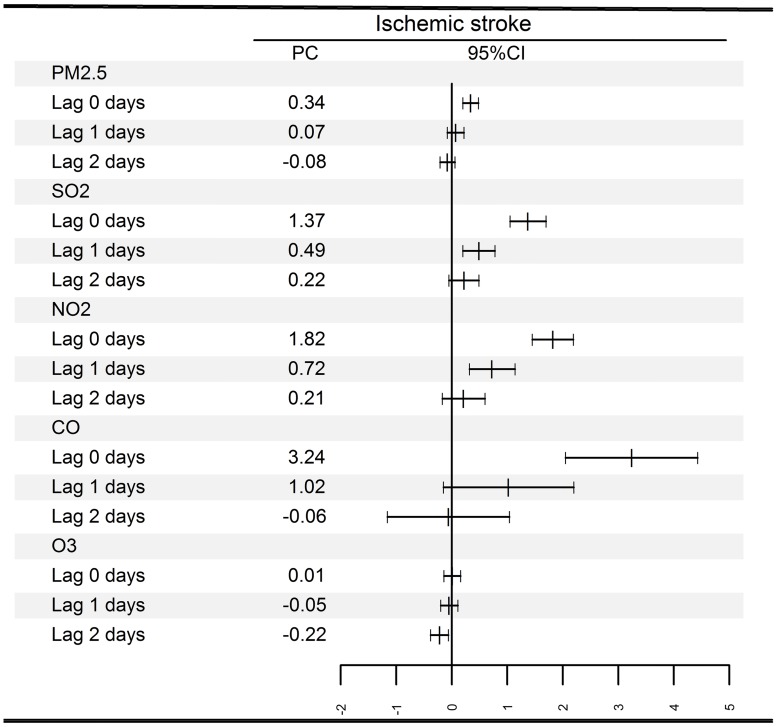
PC and 95% CI in daily hospital admissions for ischemic stroke associated with increases of 10 μg/m3 in PM2.5, SO2, NO2, and O3 and 1 mg/m3 in CO concentrations at different lag days.CI, confidence interval; PC, percentage change.